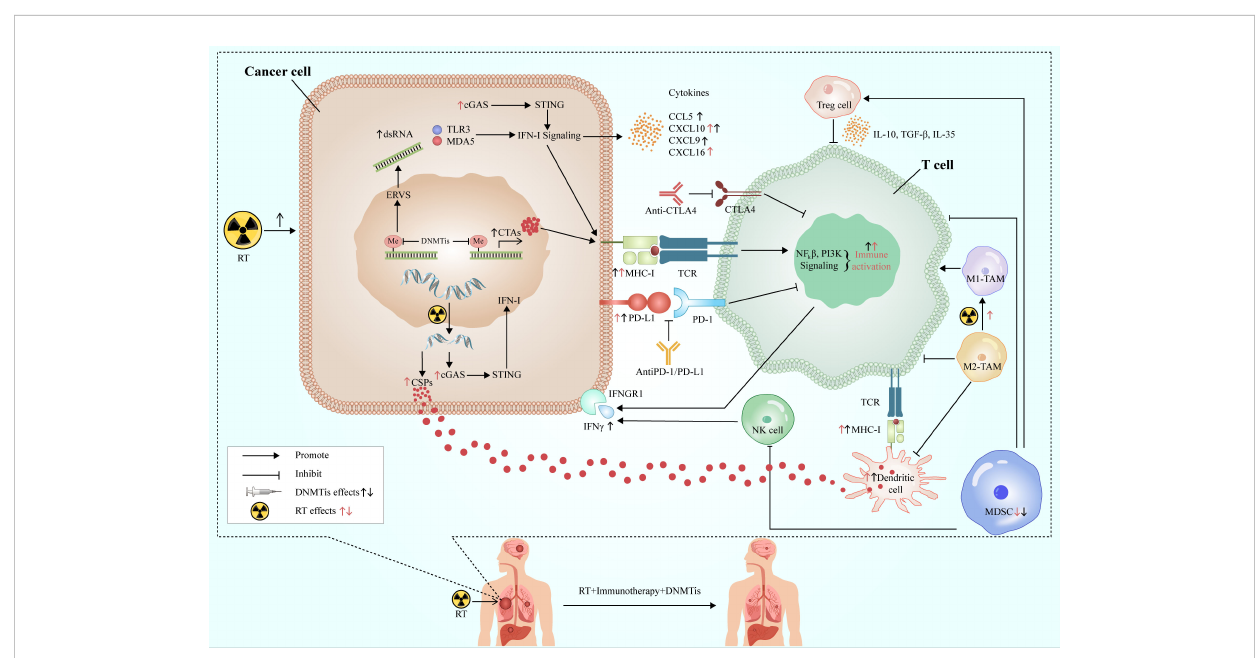
FIGURE 3 Synergistic effects of RT, immunotherapy and DNMTis. RT acts on cancer cells to produce double-stranded DNA, release cancer-speci fi c peptides, and activate the cGAS-STING-IFN-I pathway to promote anti-tumor immunity. DNMTis remove methylation from endogenous retroviruses and